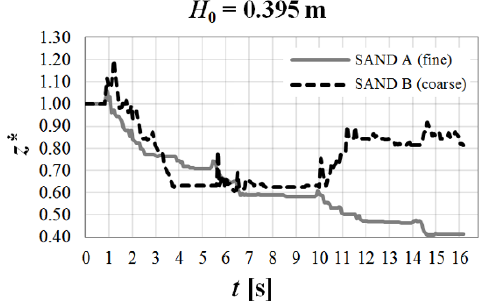
Figure 9. Experimental time evolution of z * at the dike downstream reference abscissa (+ δ ) for Tests A3 and